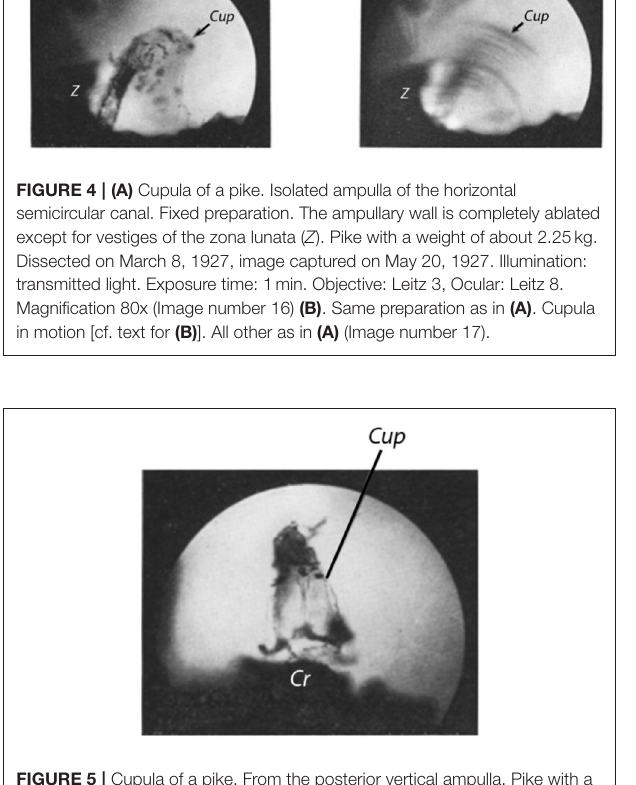
FIGURE 5 | Cupula of a pike. From the posterior vertical ampulla. Pike with a weight of 0.5kg. Fixed preparation. Dissected on May 20, 1927,